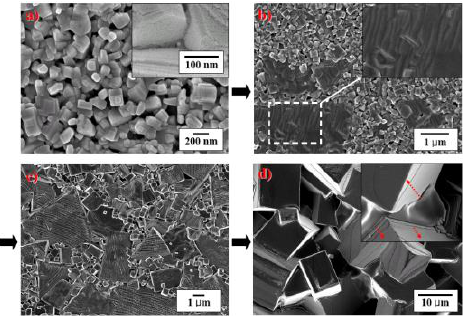
Figure 5. SEM images of the specimens sintered at various temperatures in KNLN-BT ceramics: (a) 950 °C; (b) 980 °C; (c) 1030 °C; and (d) 1080